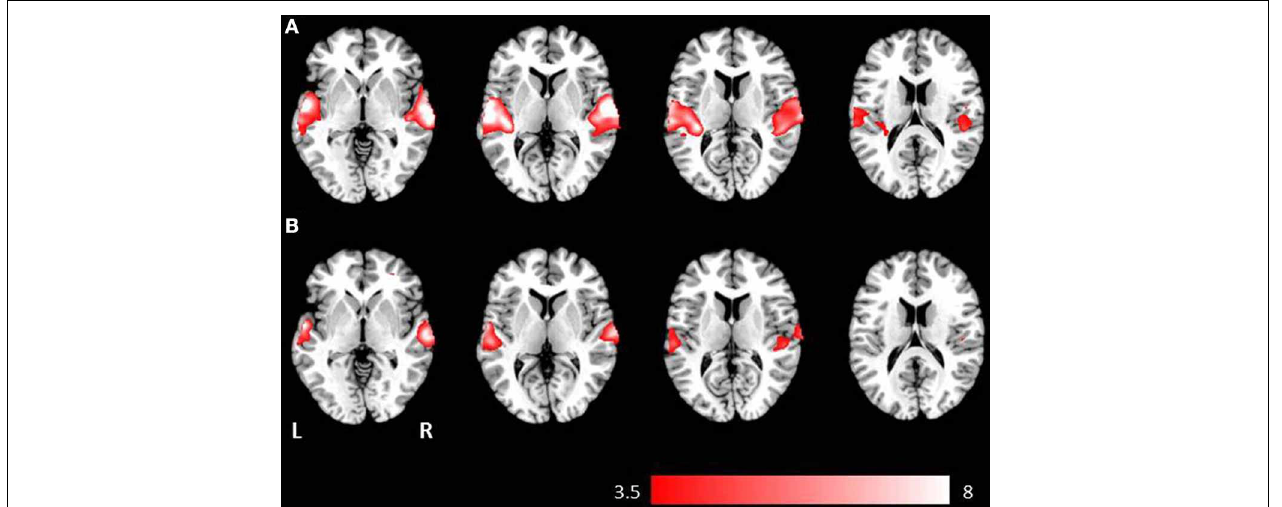
FIGURE 2 | Axial mean anatomical images overlaid with brain activation resulting from second-level GLM analysis, revealing higher brain activity for auditory presentation compared to visual presentation ( p < 0 . 001, uncorrected) induced by (A) the phrases task and (B) the verb generation task.